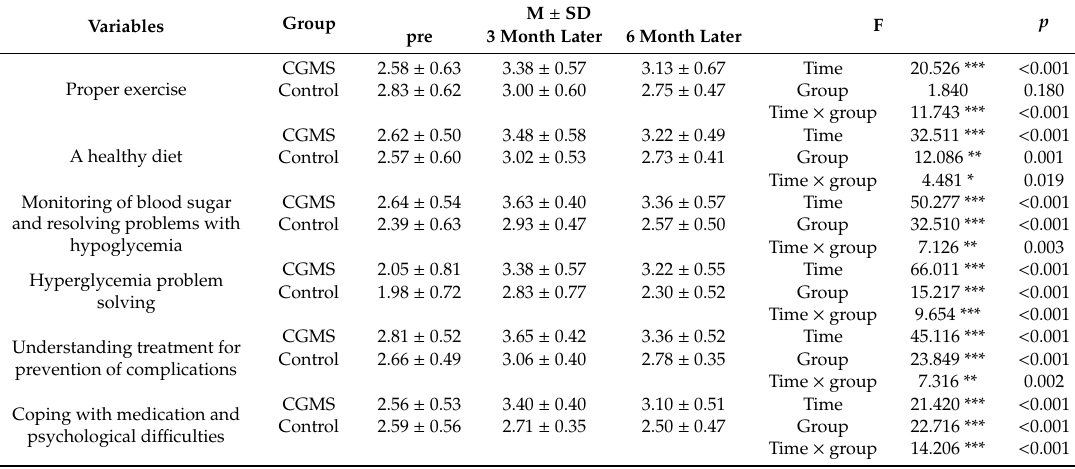
Table 4. Di ff erence of self-e ffi cacy factors according to Table 4. Difference of self-efficacy factors according to group.